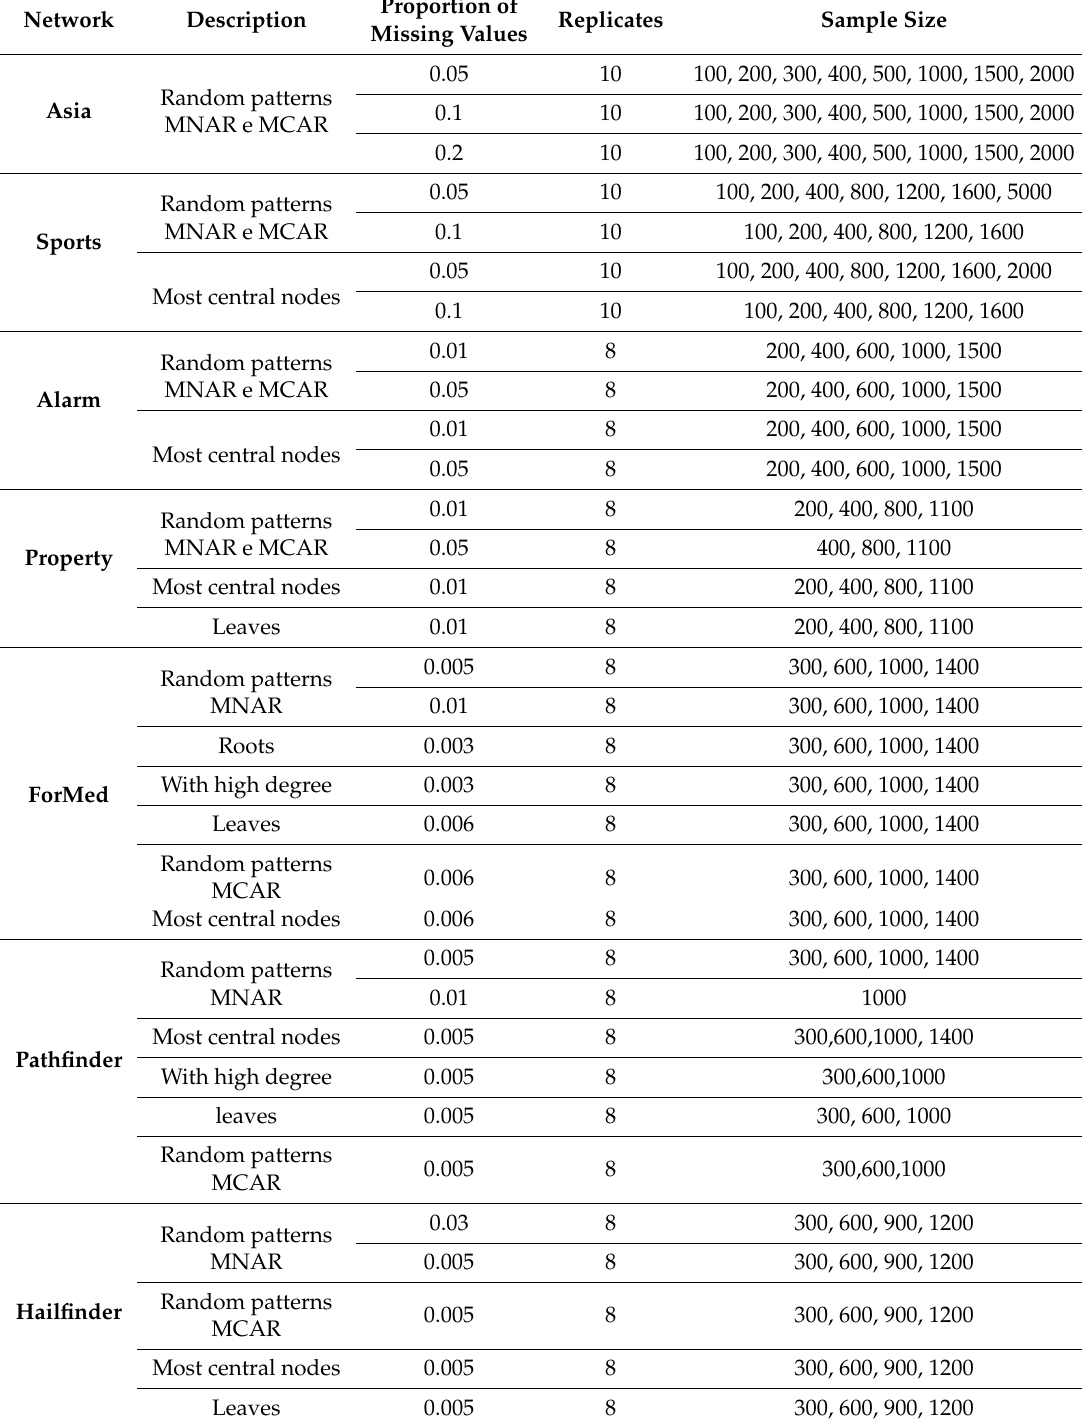
Table A1. Complete description of all the combinations of experimental factors covered in the simulation